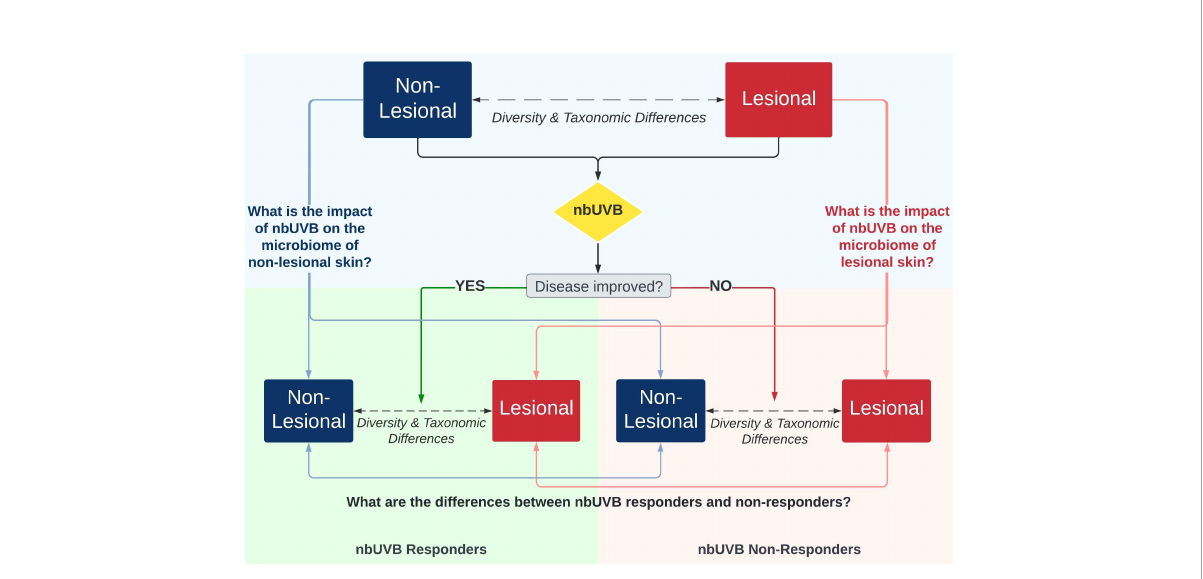
FIGURE 1 Investigational schemata for evaluating the skin microbiome of lesional and non-lesional cutaneous T-cell lymphoma (CTCL) skin in response to narrowband ultraviolet B (nbUVB) phototherapy. Differences in microbial community diversity and taxonomic abundance between responders and non-responders are illustrated in Figures 2 –